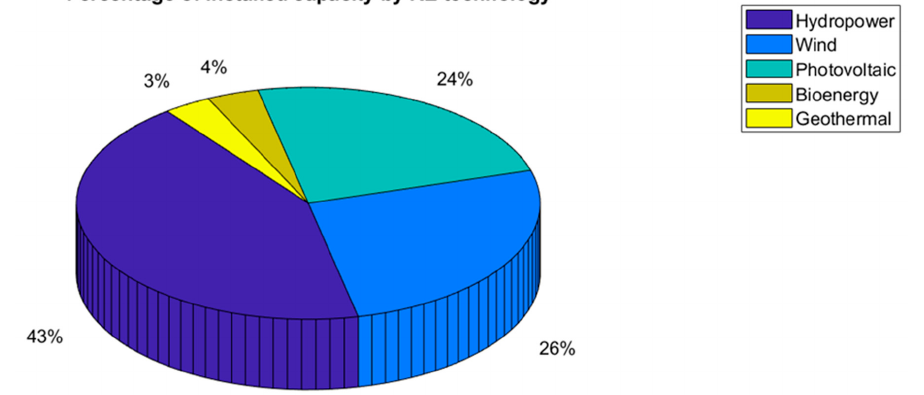
Figure 3. Renewable energy percentage in Mexico by technology (2021).